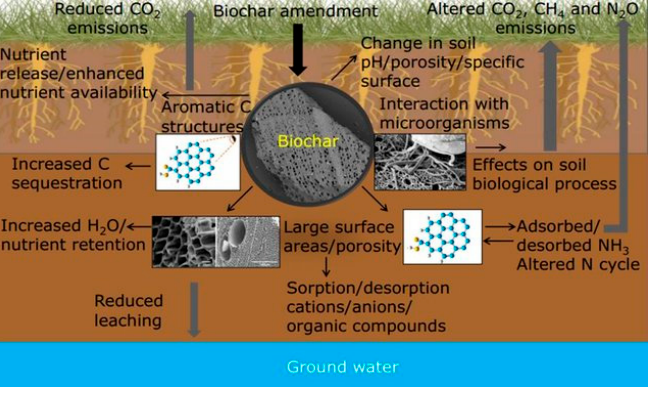
Figure 1. Schematic diagram of influence of biochar in soil [9].